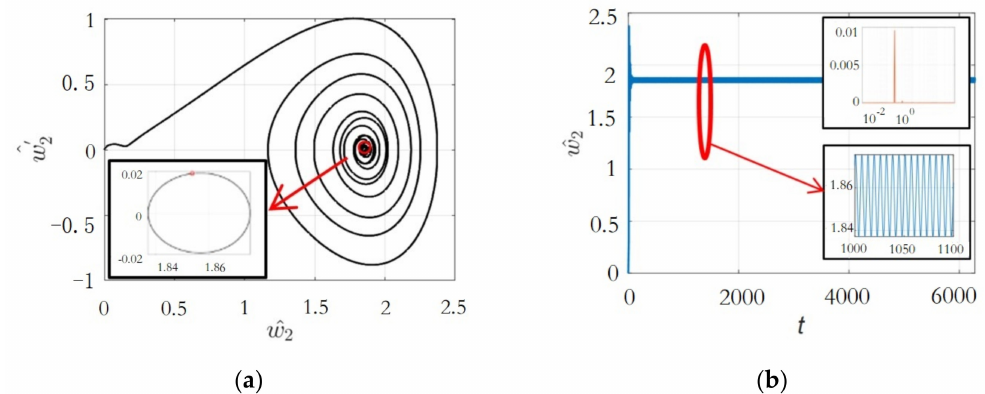
Figure 16. Periodical analysis of horizontal displacement: ( a ) Poincar é phase diagram; ( b ) time history.